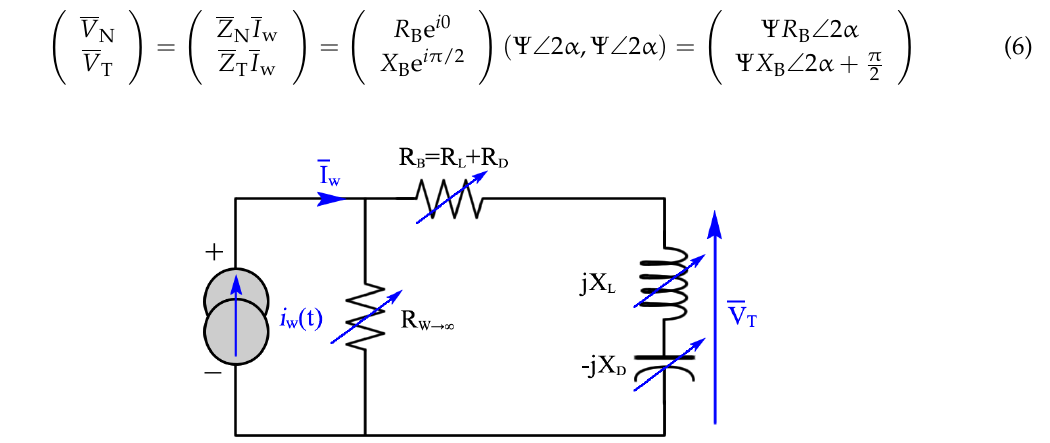
Figure 7. Electric circuit model for a single blade.